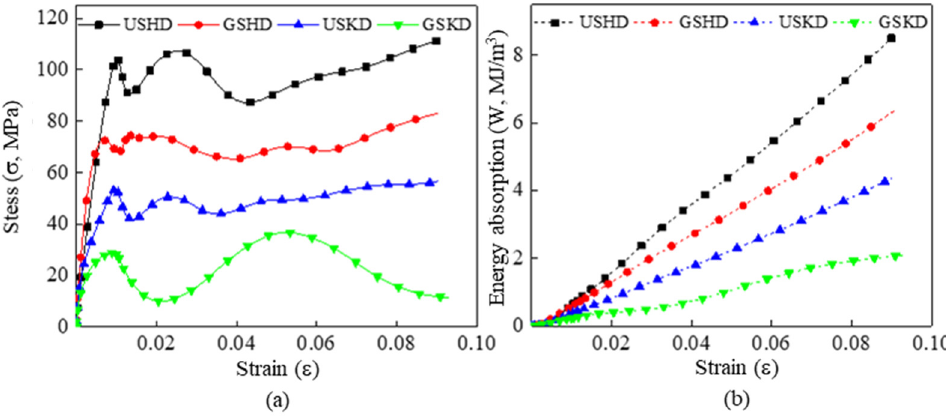
Figure 5. ( a ) Stress–strain and ( b ) strain–energy absorption curves under a strain rate of 650/s.